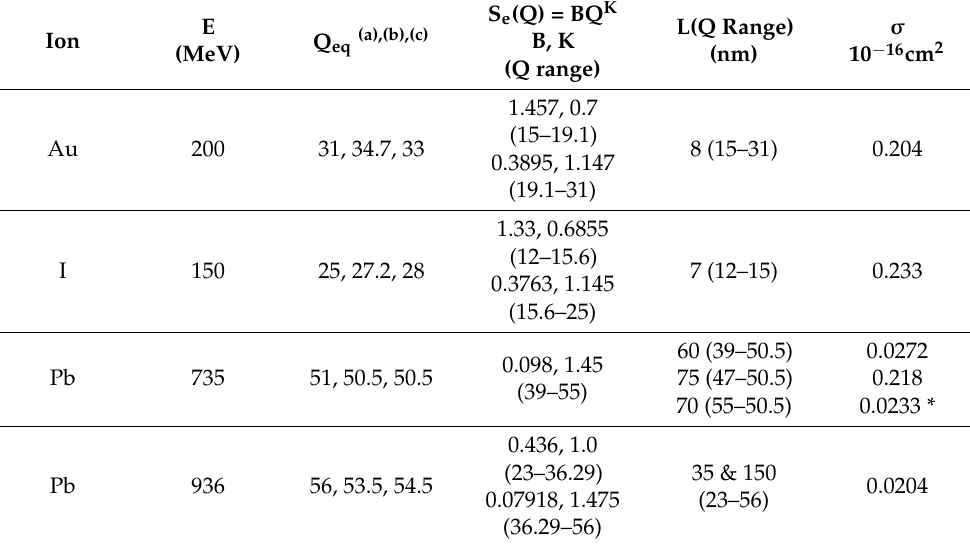
Table 7. Ion, energy (E in MeV), equilibrium charge (Q eq ), parameters of the power-law fit to the charge (Q)-dependent electronic stopping power S e (keV/nm) and the range of Q in parenthesis for LiF. L is the characteristic length in the saturation fit (Equation (2a) or (2b)) to the mean-charge evolution and σ is the corresponding electron loss and capture cross sections ( σ = 1/NL) for increasing charge, except for decreasing charge (Q o = 55–50.5, 735 MeV Pb denoted by *). N = 6.13 × 10 22 cm − 3 (Li density, see Table